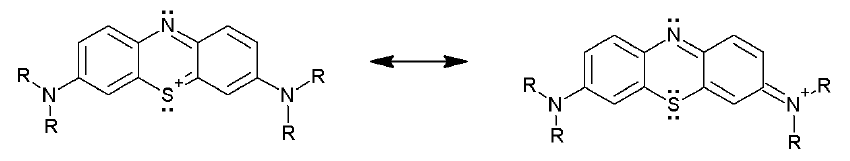
Figure 3 . Electron resonance within a generic thionine.